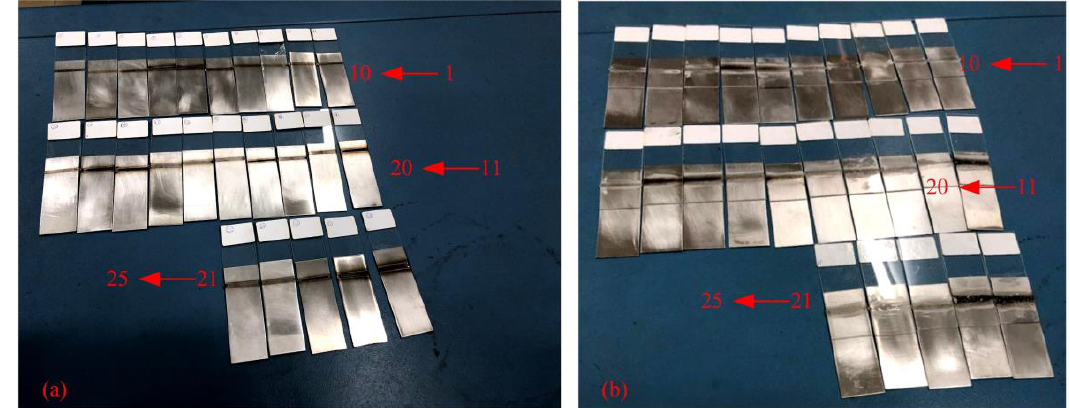
Figure 3. Macroscopic weld surface morphologies of 25 hybrid joints samples: ( a ) 304 austenitic stainless sheet side and ( b ) PMMA side.